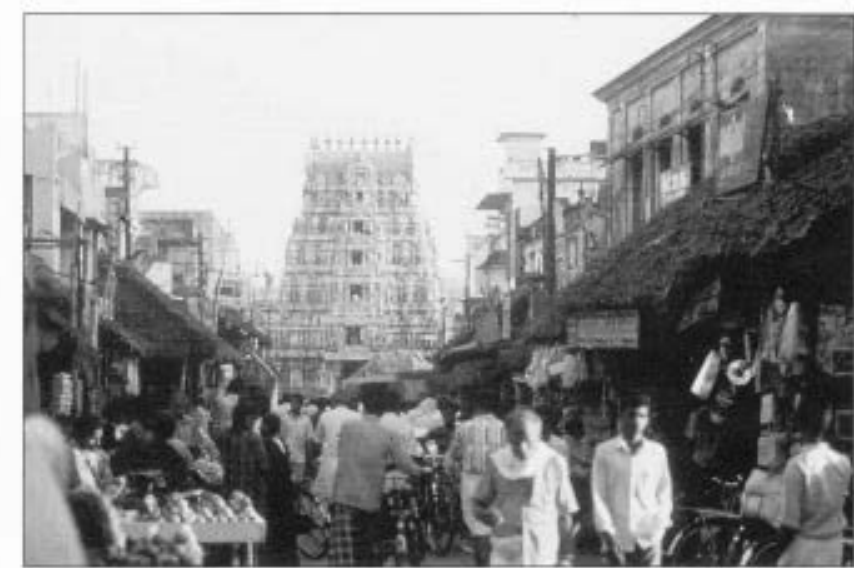
Figure 7 Bazaar street with the Ramasvamy temple at its southern